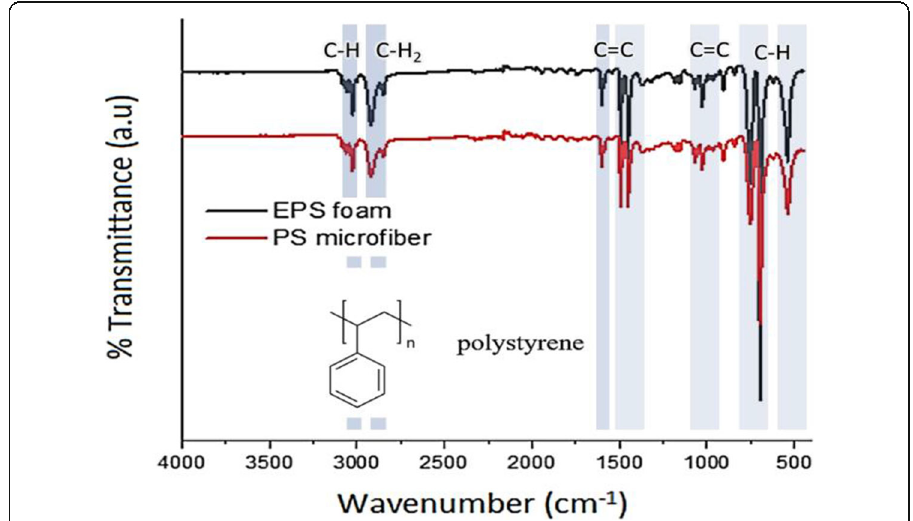
Fig. 3 FTIR spectra of EPS foam and PS